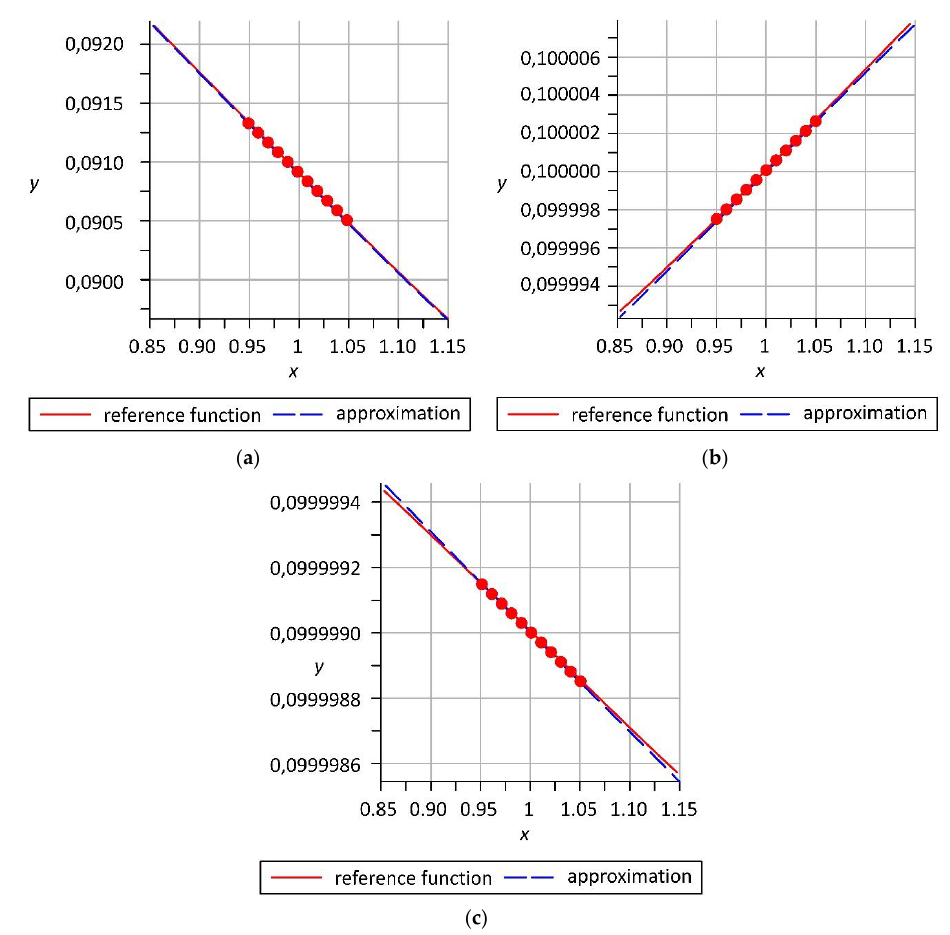
Figure 12. Diagrams of approximations (maximizing RMSE mod ) in relation to the reference functions and the discrete data generated: ( a ) A results, ( b ) B results, ( c ) C results. Table 5. Exemplary results obtained using the adopted criterion (the most important differences are underlined).